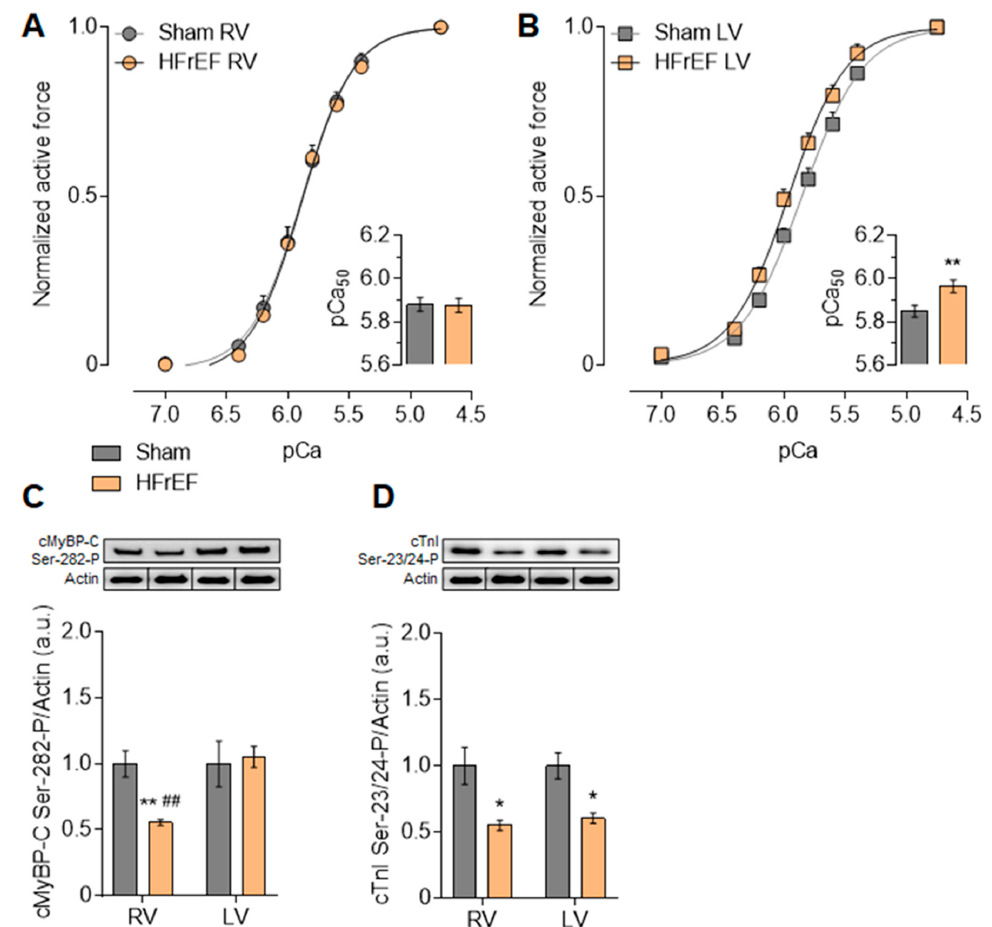
Figure 5. Interventricular differences of myofilament Ca 2+ -sensitivity and protein phosphorylation in the post-ischemic rat heart. Ca 2+ -sensitivities of the contractile machinery of RV ( A ) and LV ( B ) cardiomyocytes are indicated by the pCa 50 values ( small panels ) derived from normalized active force vs. pCa (–log 10 [Ca 2+ ]) relationships. Cardiac myosin binding protein-C (cMyBP-C) phosphorylation at Ser-282 ( C ) and cardiac Troponin I (cTnI) bis-phosphorylation at Ser-23/24 ( D ) are shown after normalization to actin. Insets: Representative images show Western immunoblots using P-site-specific anti-cMyBP-C and anti-cTnI antibodies (top) and corresponding anti-actin antibodies (bottom; discontinuity of the blots indicates identical samples from parallel experiments with different loading order) at molecular weights of ~150 kDa (cMyBP-C), ~24 kDa (cTnI), and ~42 kDa (actin). Data are shown as mean ± SEM; panels A–B: n = 10–13 cardiomyocyte/3–5 heart/group; panels C–D: n = 4–9 sample/3–5 heart/group. * p < 0.05, ** p < 0.01 HFrEF vs. Sham (same ventricle); ## p < 0.01 RV vs. LV (same group).